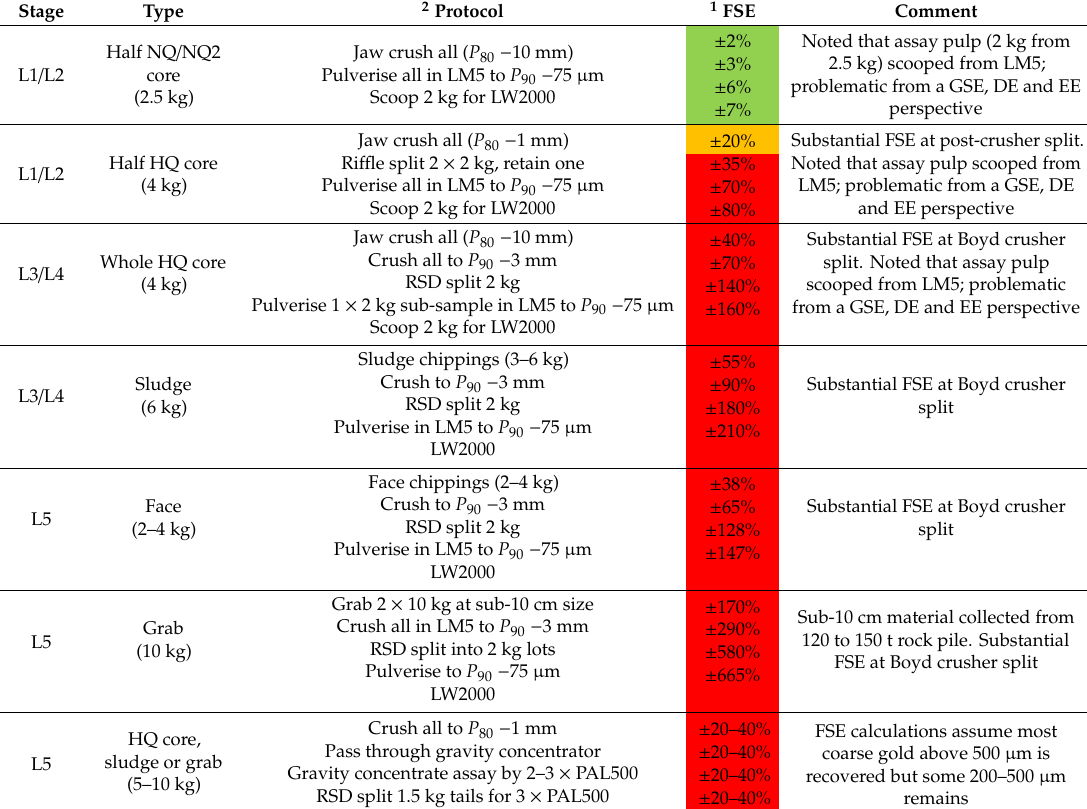
Table 11. Protocols and FSE for L1-L5 (Table 10) at BCOG across d 95Au scenarios (Table 6) for the LGL operating period. FSE calculations assume coarse gold in the